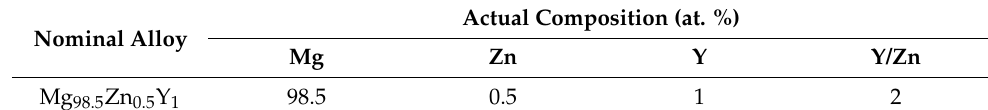
98.5 Zn 0.5 Y 1 alloy.